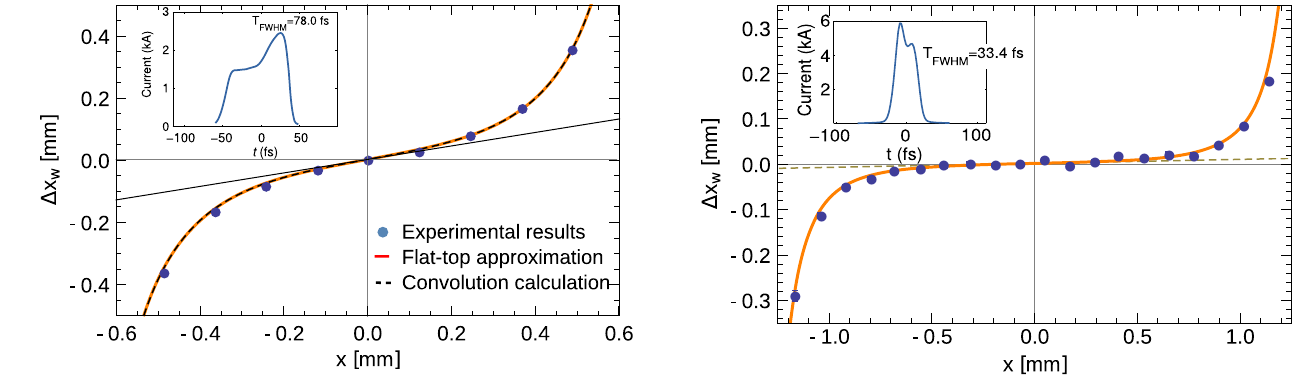
FIG. 4. Deflection as function of beam offset from the axis in one dechirper module, showing data (plotting symbols) and calculations (flat-top approximation, the curve), for half gap a ¼ 1 . 55 mm. Note that the error bars in the data are small and barely visible. The gap in the analytical calculation was reduced by 6% to fit the experimental data. The straight line gives the slope of the curve at the origin. The bunch shape, with head to the left, is given in the inset